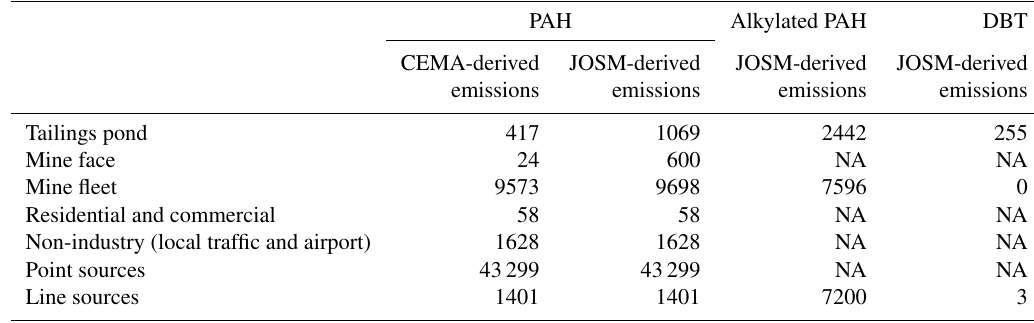
Table 1. Estimated PAH, alkylated PAH, and DBT emissions (kgyr − 1 ) over the model